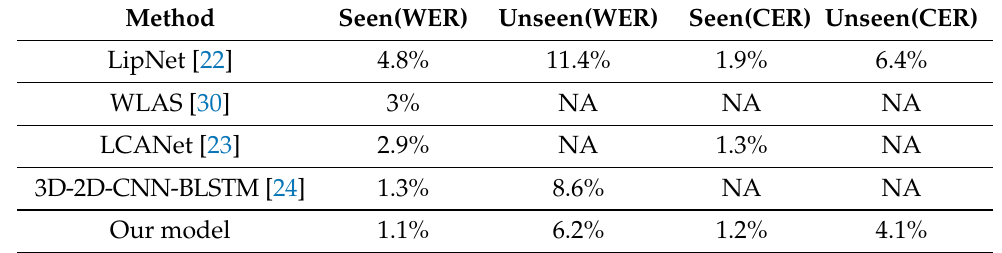
Table 3. Performance on the GRID dataset.